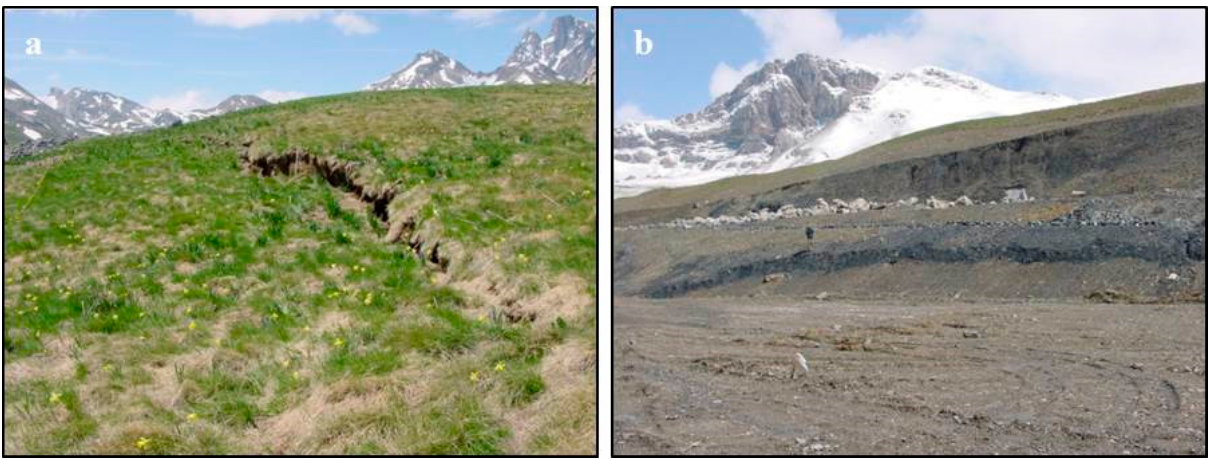
Figure 6. Daylight of the failure surface: ( a ) stress crack; ( b ) warped plane morphology.